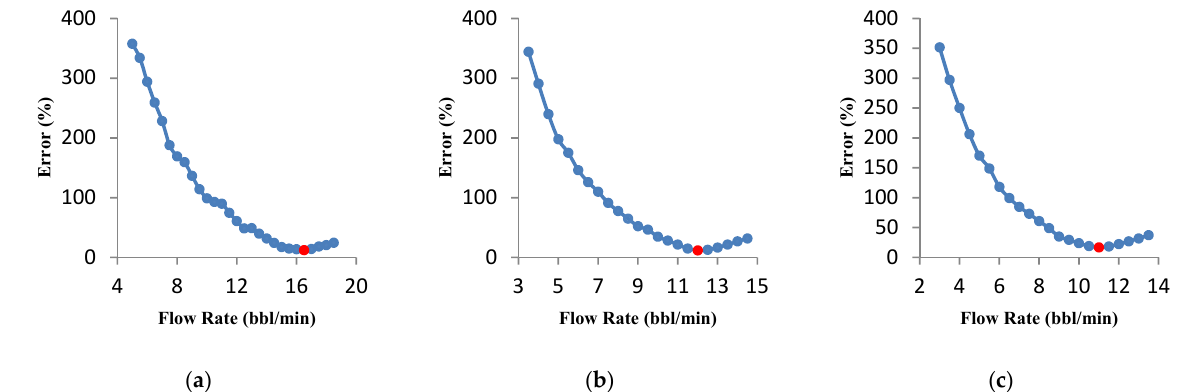
Figure 13. Results of flow rate optimization for three acid systems types investigated for a 540 bbl acid. ( a ) straight acid, ( b ) gelled acid, and ( c ) emulsified acid.